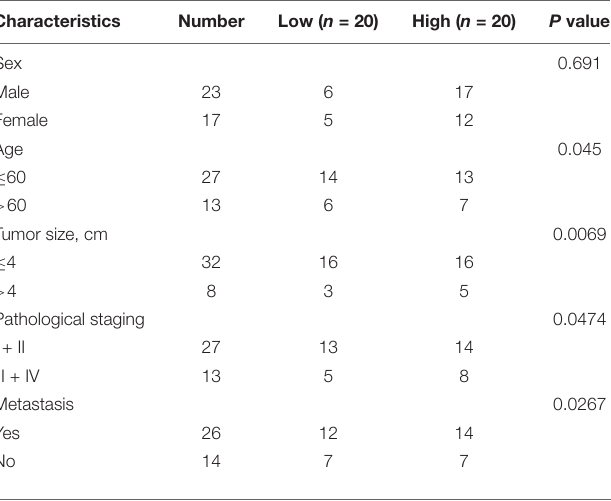
TABLE 1 | Association of PRMT5 expression with clinicopathological features of patients with ESCC.